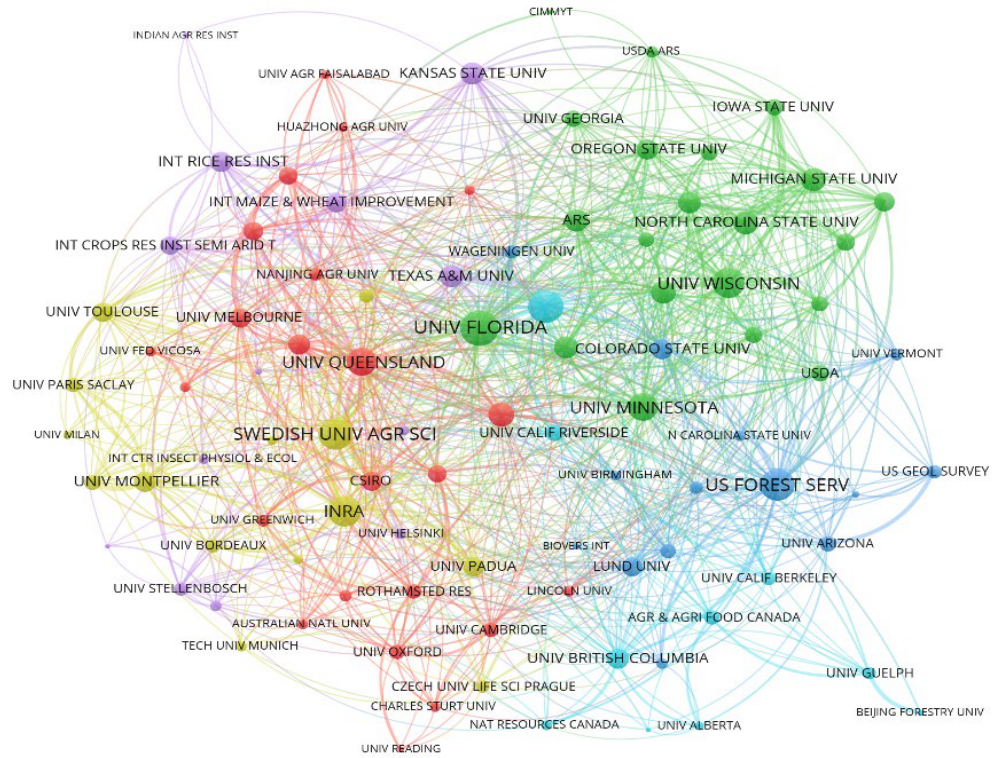
Figure 5. Knowledge map of relevant institutions in the field of climate change’s impact on crop pest and disease research. Table 5. Top 15 funding